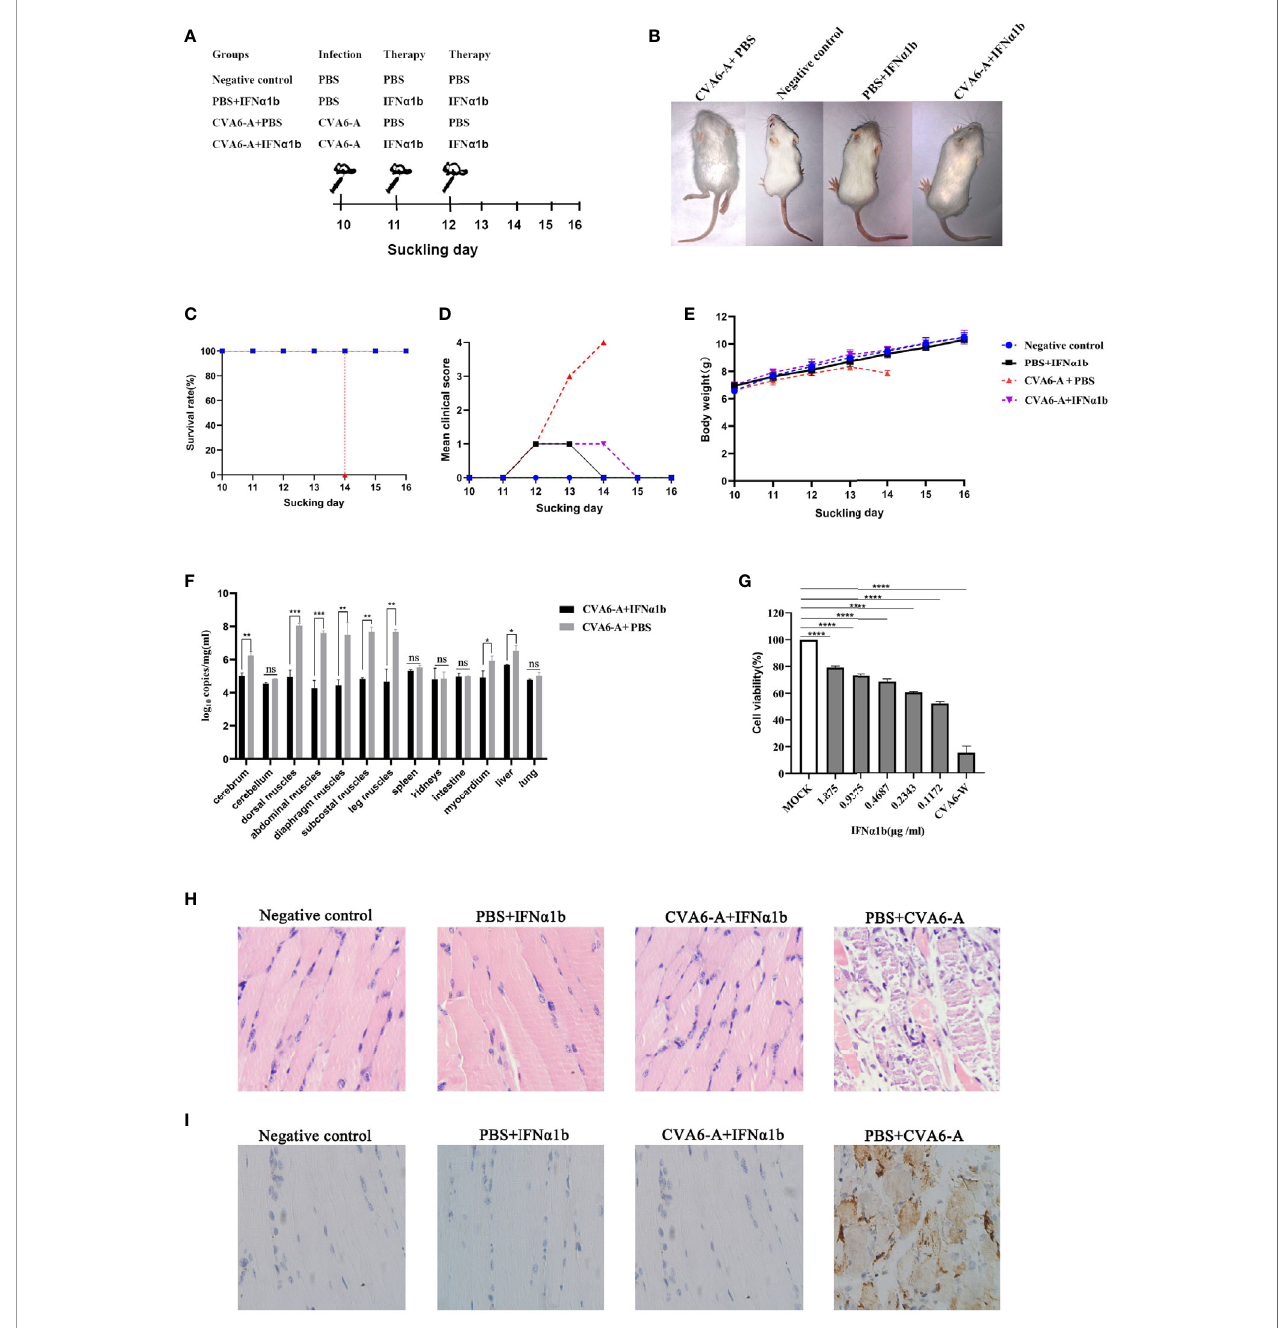
FIGURE 5 | The therapy effects of IFN- a 1b against coxsackievirus A6 (CVA6) infection in 10-day-old suckling mice. (A) The diagram showing IFN- a 1b treatment of CVA6-A infection among 10-day-old suckling mice. The infected mice (n = 5) were given IFN- a 1b therapy twice after CVA6-A infection, and the infection control group mice (n = 5) were injected with an identical volume of PBS instead of IFN- a 1b after CVA6-A infection. The negative control group and IFN- a 1b control group mice were not infected with CVA6-A. After being treated twice with IFN- a 1b, no differences were observed between the suckling mice injected with CVA6-A and IFN- a 1b and the negative controls (B) . The survival rates (C) , clinical scores (D) , and body weight change (E) were the main factors measured daily until 6 dpi. The main tissues of the infected and treatment group mice were collected to detect the viral loads by using qPCR, and posttreatment with IFN- a 1b, in which the viral load was identi fi ed to be signi fi cantly lower than that of the untreated group (F) . In vitro, after CVA6-W infected RD cells, IFN- a 1b was suggested to inhibit CVA6-W activities via CCK-8 detection (G) . *p < 0.05; **p < 0.01; ***p < 0.001, ****p < 0.0001. n.s., insigni fi cant result. Ten-day-old suckling mice were intraperitoneally injected with a lethal dose of CVA6-A, a similar viral load of CVA6-W, as well as an identical volume of DMEM. The histopathological (H) and immunohistochemical (IHC) (I) examinations of the leg muscle tissues of the CVA6-A infected mice treated with IFN- a 1b or PBS (200×). The leg muscles were made into pathological sections and then observed (H) . IHC examination was performed using anti-CVA6 VP2 antibody (I)